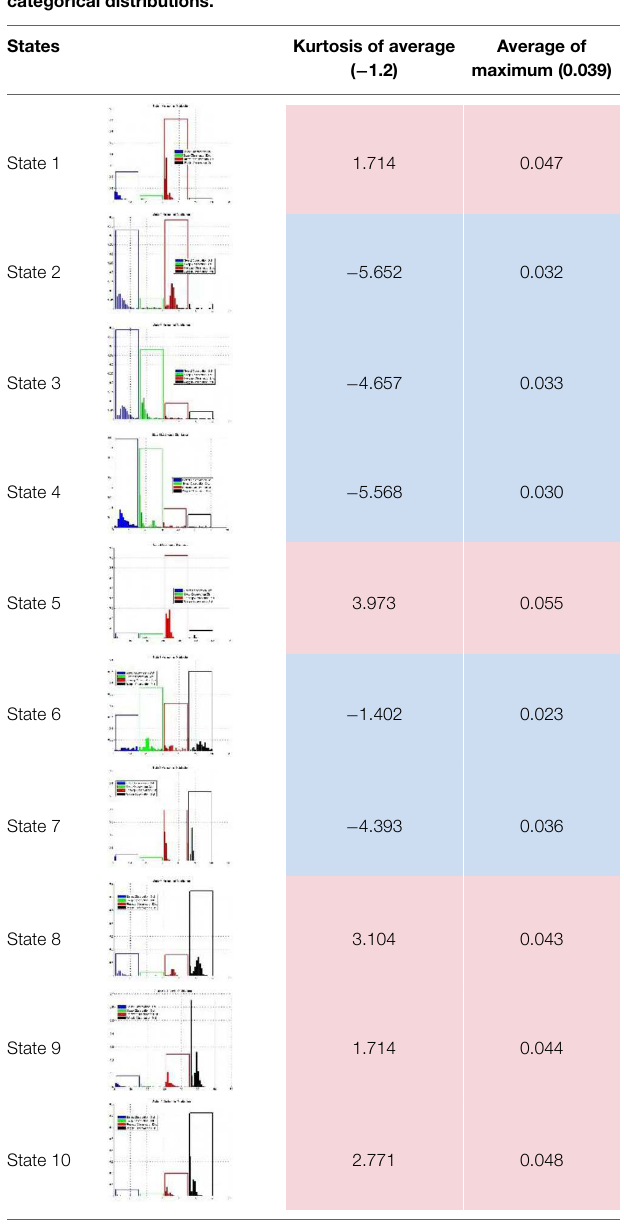
Values indicate metrics describing the peakedness of categorical state distributions from centroid values. Parentheses indicate cutoff points for classification—excess values are classified as peaked. Red colored cells are classified as peaked states, blue as diffuse states.